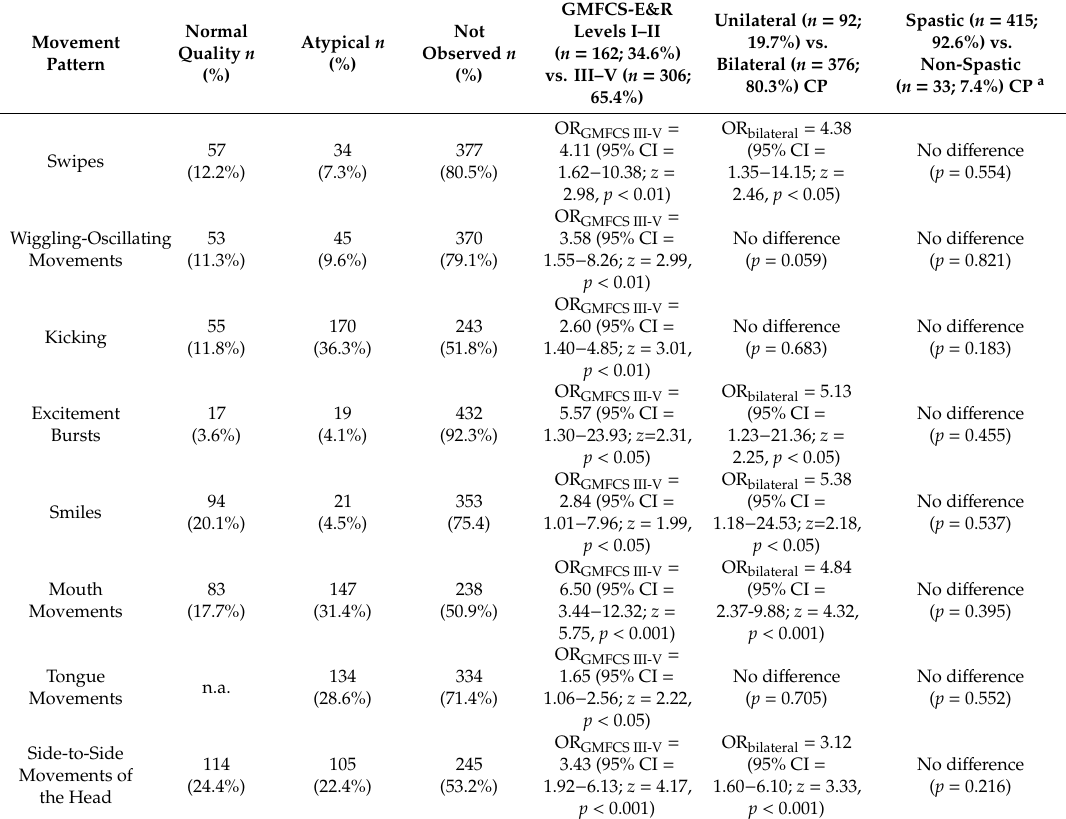
Table 4. Movement patterns at 3 to 5 months and their normal vs. atypical occurrence in 468 infants later diagnosed with cerebral palsy